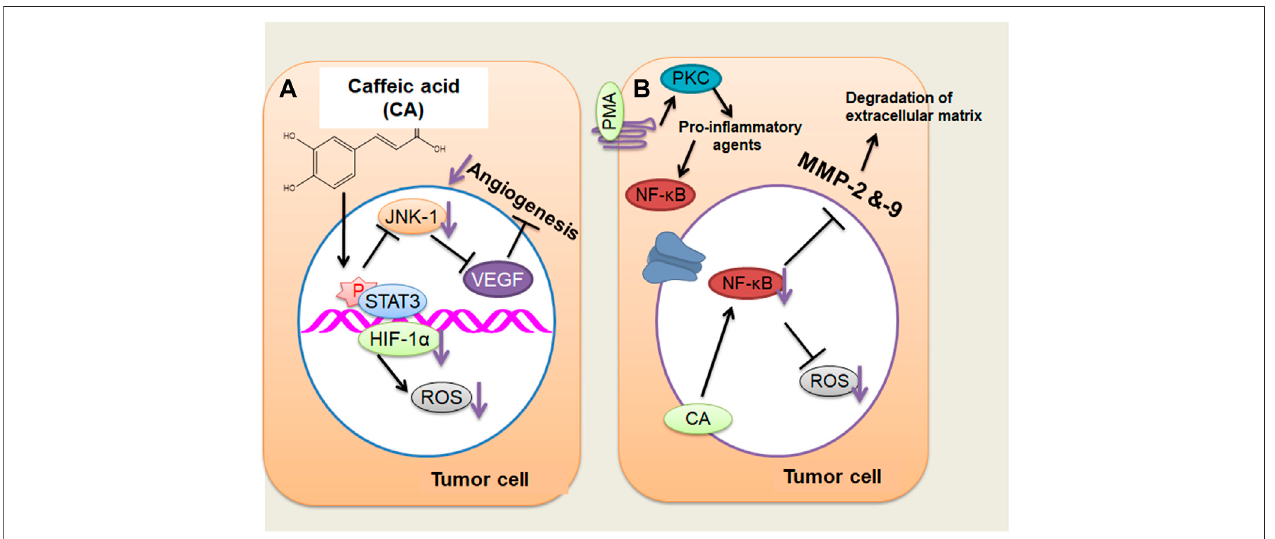
FIGURE1|(A) Caffeicacid(CA)actionsontheangiogenesisofcancercellsthroughdecreasingtheJNK-1phosphorylationandreducingtheHIF-1 α activationthat cause the decline of vascularization mediated by vascular endothelial growth factor. (B) CA may act on tumor cells by repressing MMP-2 and MMP-9 expressions, which, in turn, inhibits the activation of NF- κ B stimulated through PMA (activating protein 1) in tumor cells, thus reducing cancer invasiveness and growth. ↓ , decrease. (Adapted from Espíndola et al.,